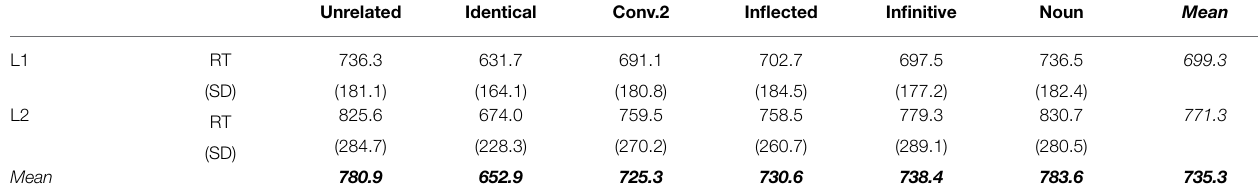
TABLE 4 | Experiment 2: mean reaction times for target phrases in ms, standard deviations (in brackets).